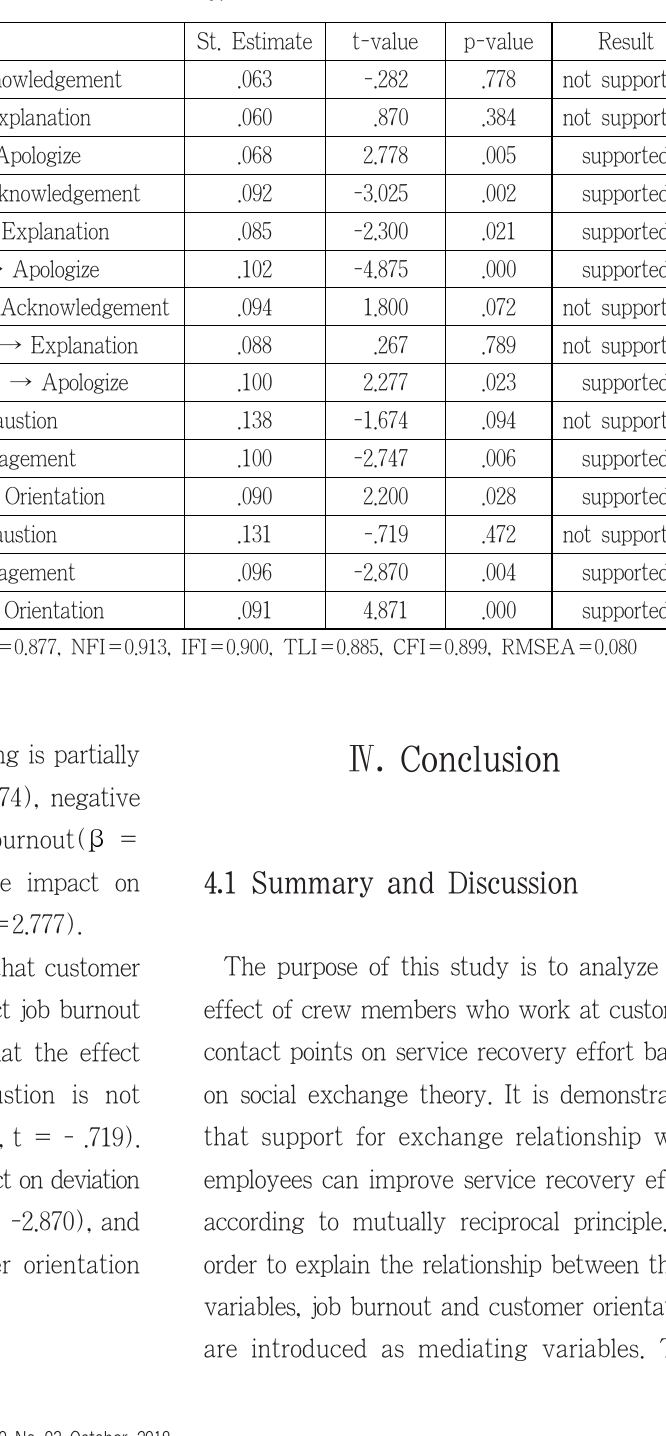
<Table 4> Results of Hypotheses